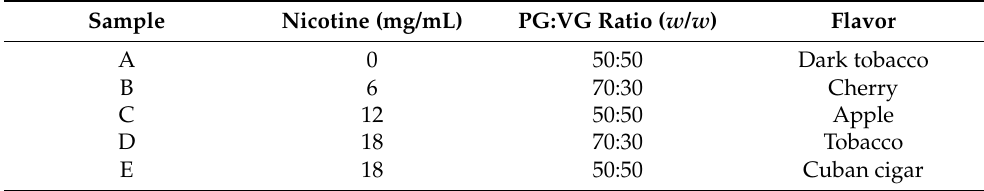
Table 1. Basic composition of EC liquids selected in this study.